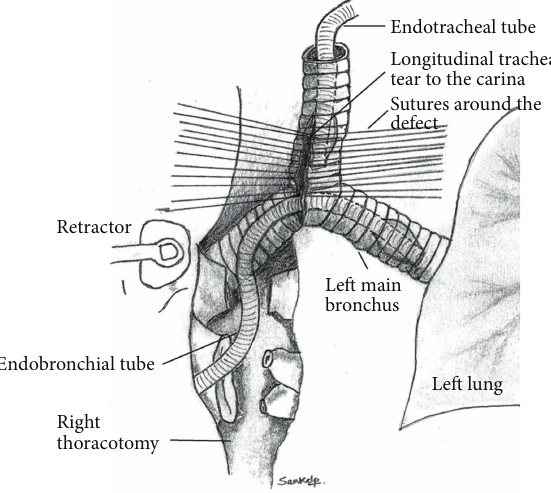
Figure 5: A sketch depicting a tracheal defect involving carina, the two main-stem bronchi, a retracted oral endotracheal tube, and an endobronchial tube placed via the open-chest thoracotomy to ventilate the left